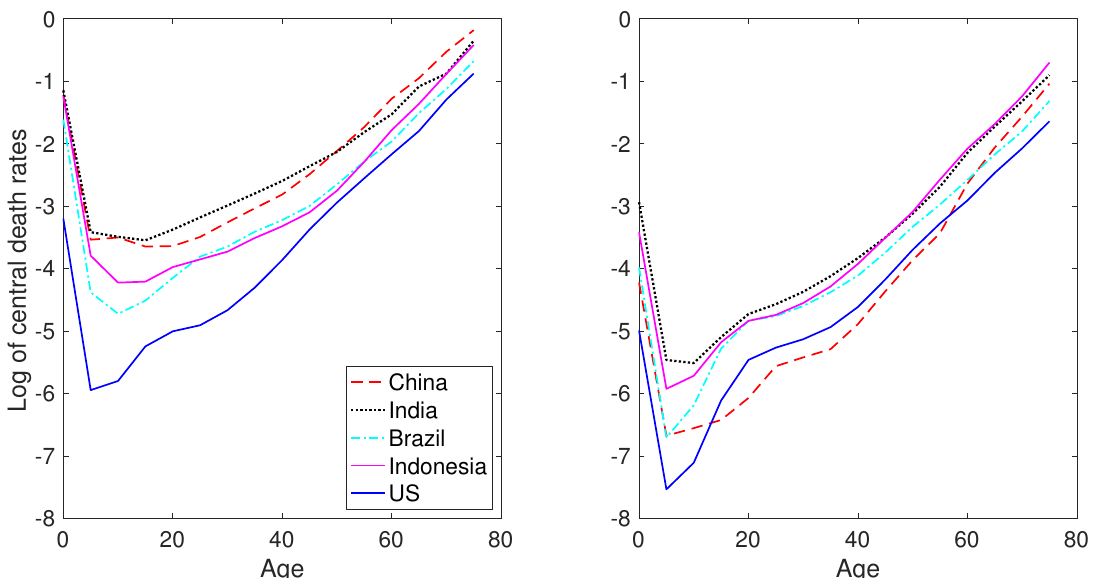
Figure 1. The logarithm of the age-specific central death rates for the five most populous countries, China, India, the US, Indonesia, and Brazil, in 1960 ( left panel ) and 2015 ( right panel